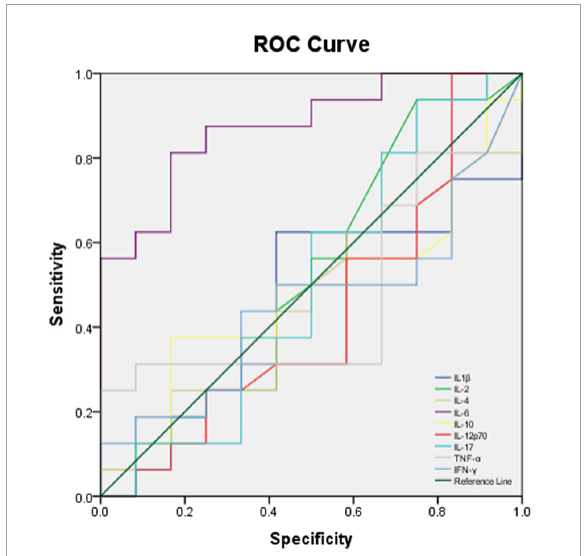
FIGURE7 ROC curve of different BALF cytokines for predicting moderate and severe cases with CAP from mild cases.